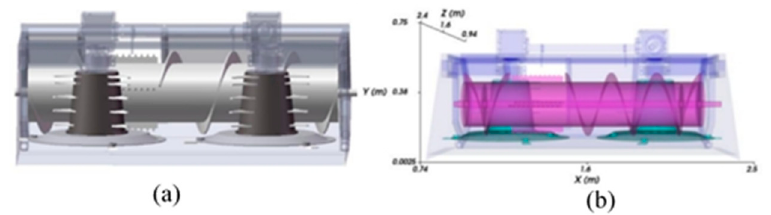
Figure 13. Discrete element model of feeding device. ( a ) Three-dimensional simplified model; ( b ) Discrete element model. Table 2. Mechanical parameters and mutual contact factors of materials.